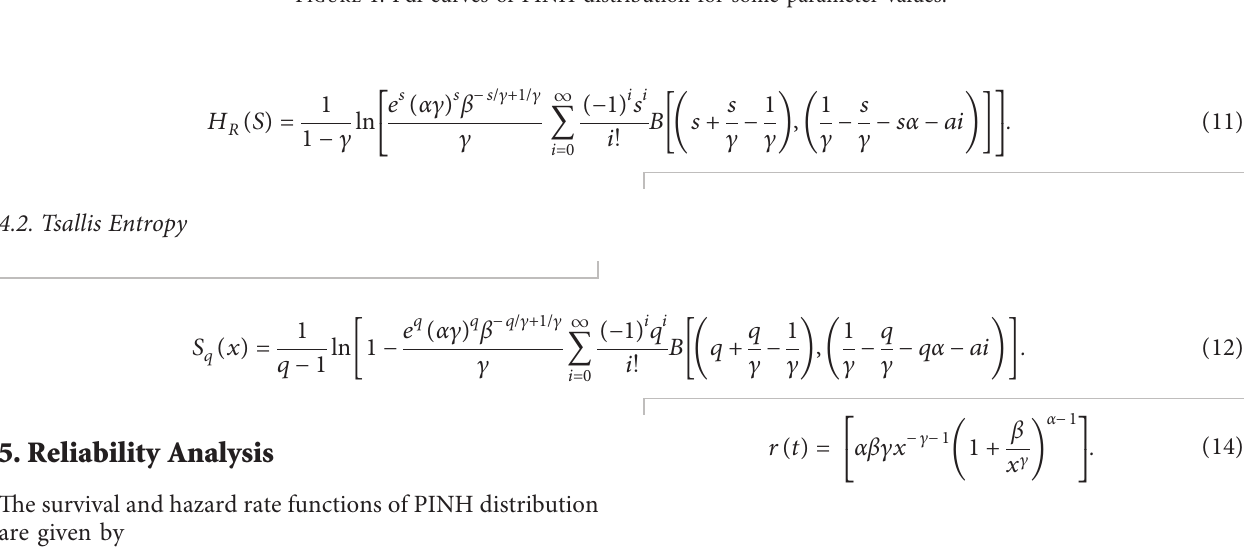
Figure 1: Pdf curves of PINH distribution for some parameter